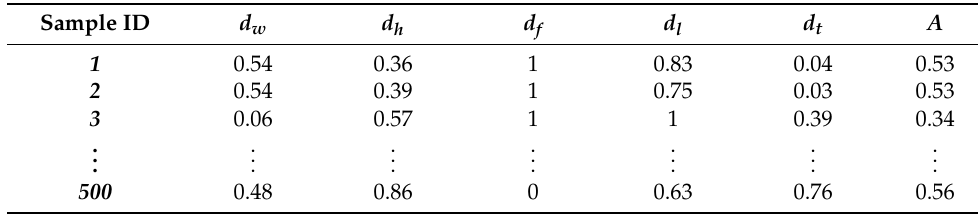
Table 7. Expanded normalized sample.